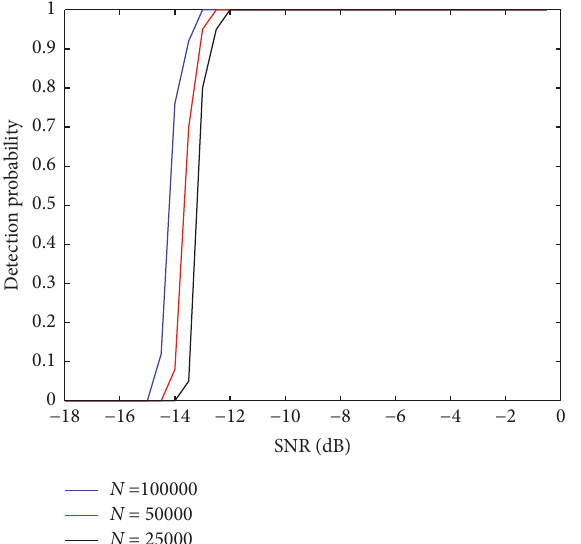
Figure 11: Detection probability for different algorithms. Table 1: The results of the peak